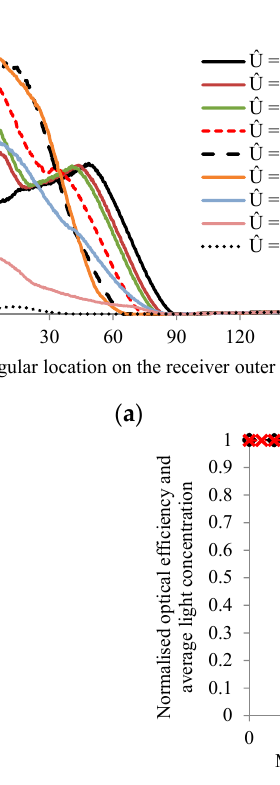
Figure 12. Actual profile versus ideal profile of a parabolic mirror. In the figure, V is the vertex of the parabola, and Û° and Ŭ ° are the inward and outward angular rotation of two halves of the mirror with respect to the vertex from its ideal profile respectively.